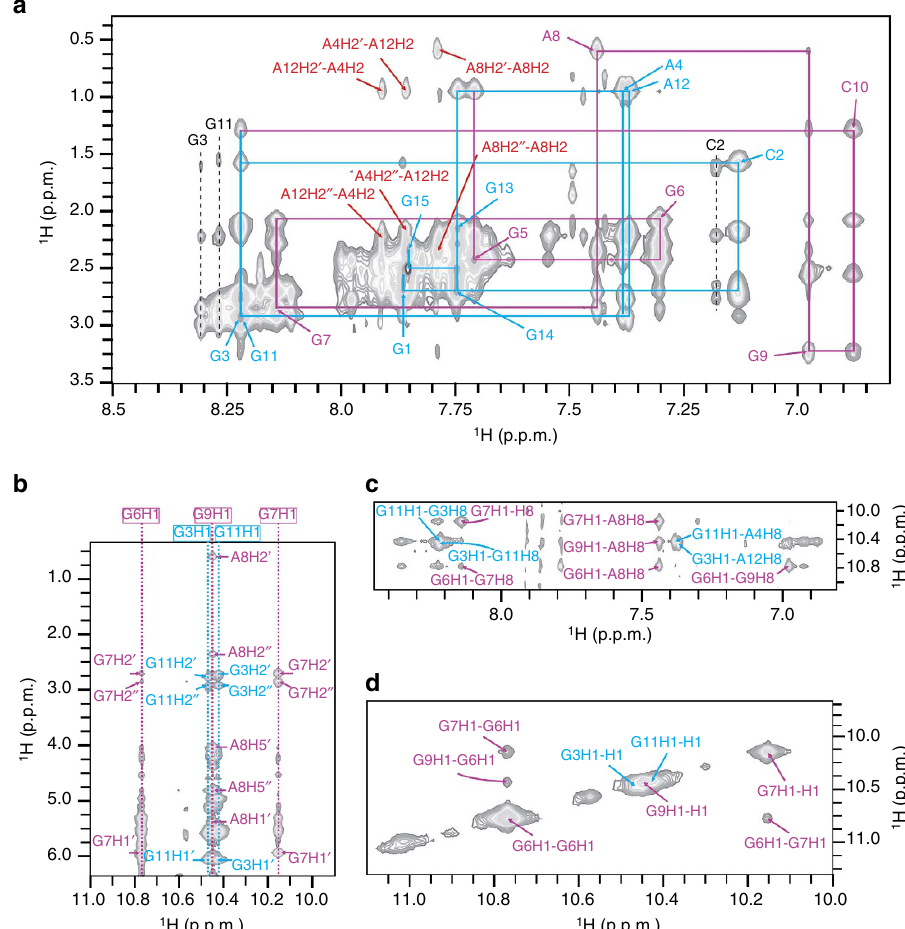
Figure 4 | NOESY spectrum of the VK34 tetramer. ( a ) H2 0 /H2 00 -aromatic region. The sequential walks from G1 to A4 and C10 to G15 are depicted in blue. The sequential walk from G5 to G9 is depicted in magenta. The NOE contacts between A4 and A12 residues as well as A8 H2 0 -A8 H2 and A8 H2 00 -A8 H2 NOE contacts are depicted in red. ( b ) Sugar-imino region. The dashed lines correspond to chemical shifts of imino proton resonances of G3, G6, G7, G9 and G11 residues. ( c ) imino-aromatic region. ( d ) imino-imino region. NOE contacts with fingerprints characteristic only for the VK34 tetramer are depicted in magenta. NOE contacts that have fingerprints similar to the VK34 dimer are depicted in blue. NOESYspectrum was recorded at 1.0mM oligonucleotide concentration per strand, 150mM NaCl, pH 6.0, 0 (cid:2) C and at mixing time of 150ms. NATURE COMMUNICATIONS|8:15355|DOI: